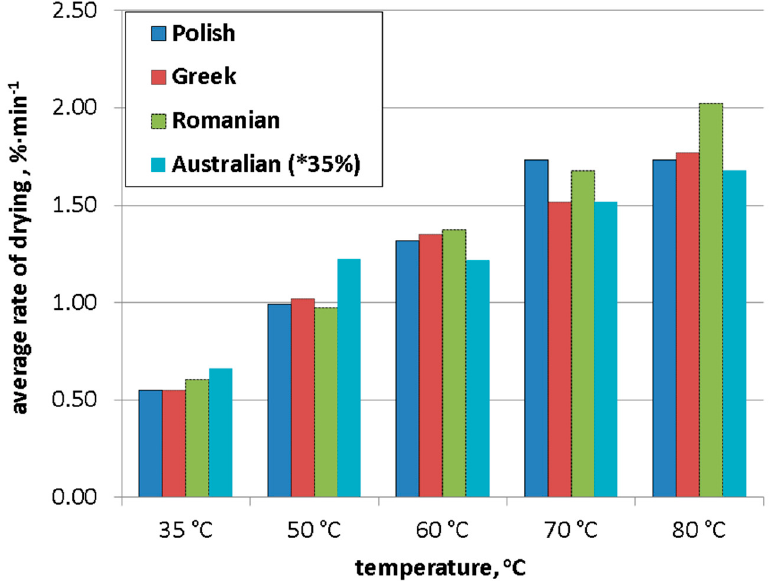
Figure 18. Average energy consumption required to achieve moisture content of 20% for tested types of lignite in the torbed installation (* energy consumption for Australian lignite is given for a final moisture content of 35%, due to a relatively high initial moisture content).